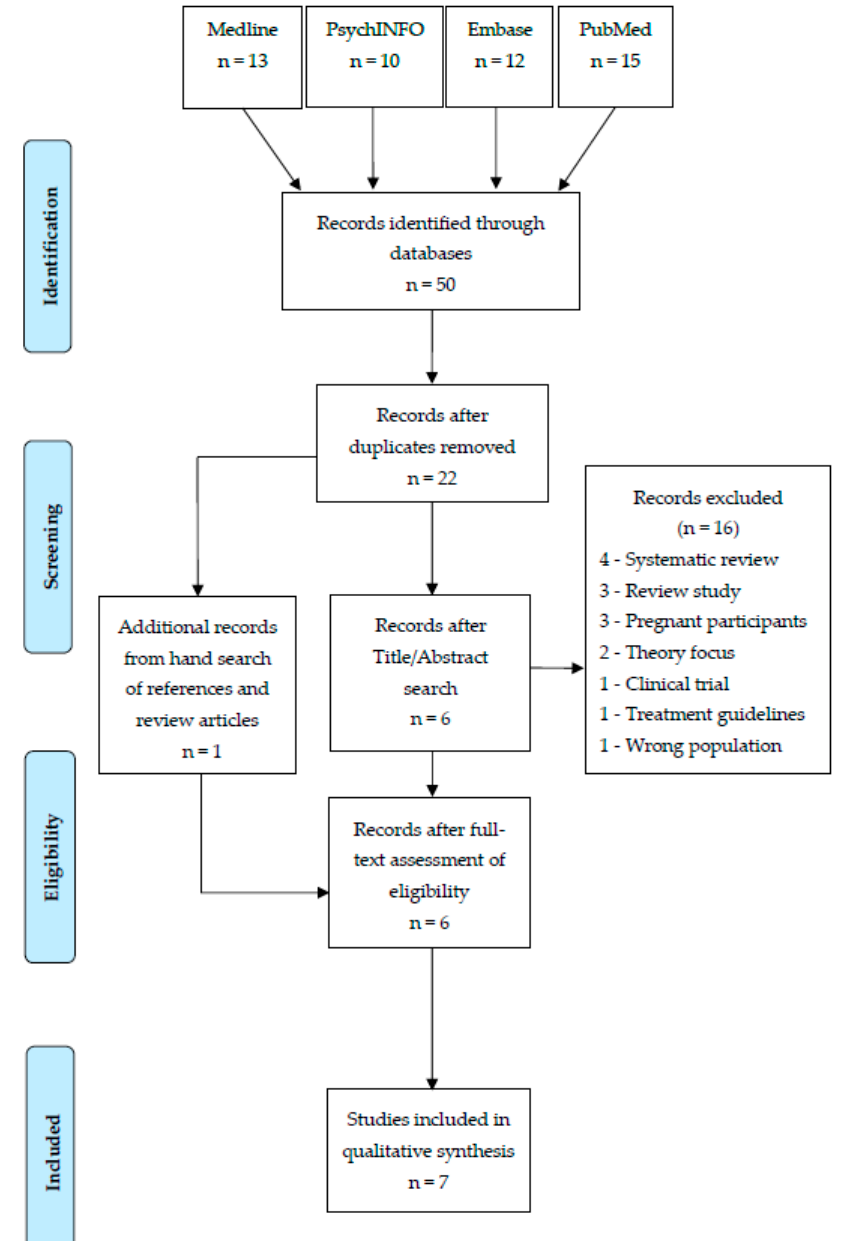
Figure 1. Study Selection PRISMA flow diagram.